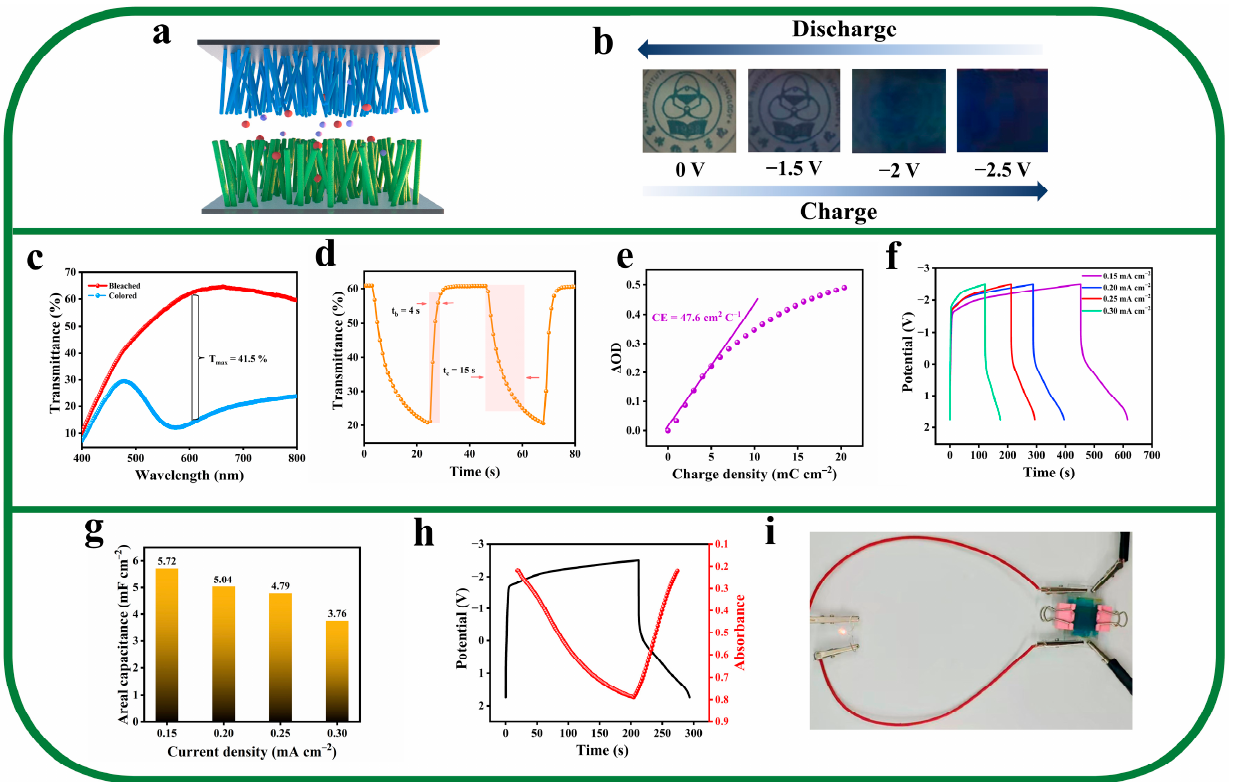
Figure 6. EC and energy storage performance of the EESD. ( a ) Configuration of the asymmetric EESD containing an NW–P 2 W 17 La film. ( b ) Digital photographs of color changes of the EESD under different voltages. ( c ) Transmittance spectra of the EESD in the bleached and colored states at 0 V and − 2.5 V in the wavelength range of 400–800 nm. ( d ) Corresponding in situ transmittance responses for 22 s per step measured at 605 nm. ( e ) CE of the EESD at 605 nm. ( f ) EESD constant current charge/discharge curve and ( g ) Area capacitance at current densities from 0.15 to 0.3 mA cm − 2 . ( h ) In situ absorbance evolution at 605 nm during the charge/discharge processes of the EESD. ( i ) Digital photograph of a fully charged bifunctional device powering a red LED.